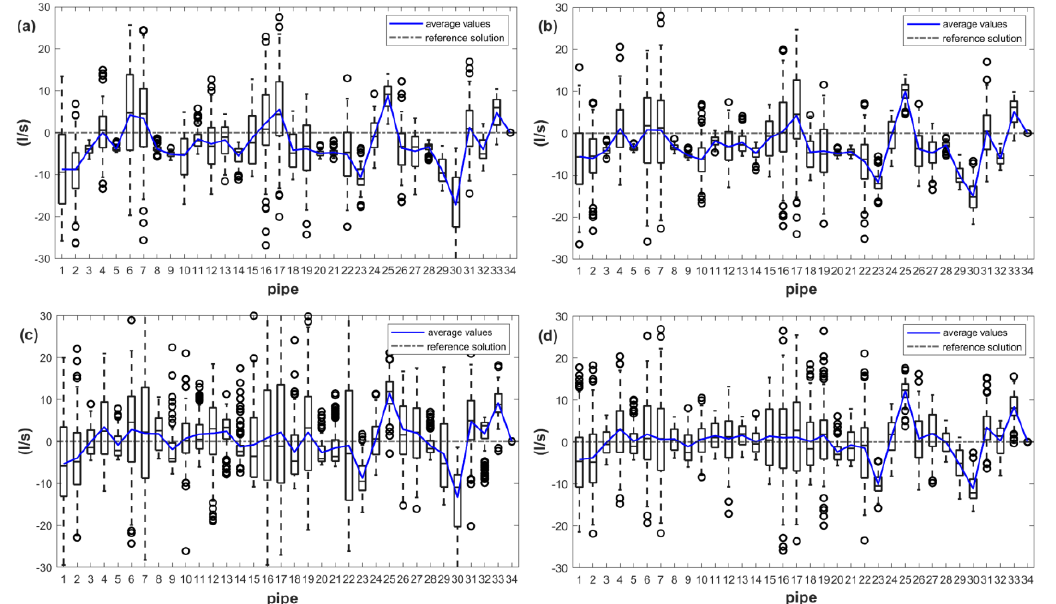
Figure 5. Flow rate errors (i.e., the difference between simulated and reference values) at each pipe of the 100 runs for each hydraulic approach: ( a ) NDD; ( b ) NPD; ( c ) DDD; ( d ) DPD. The error of the average values (i.e., average values line) is also displayed in each plot.